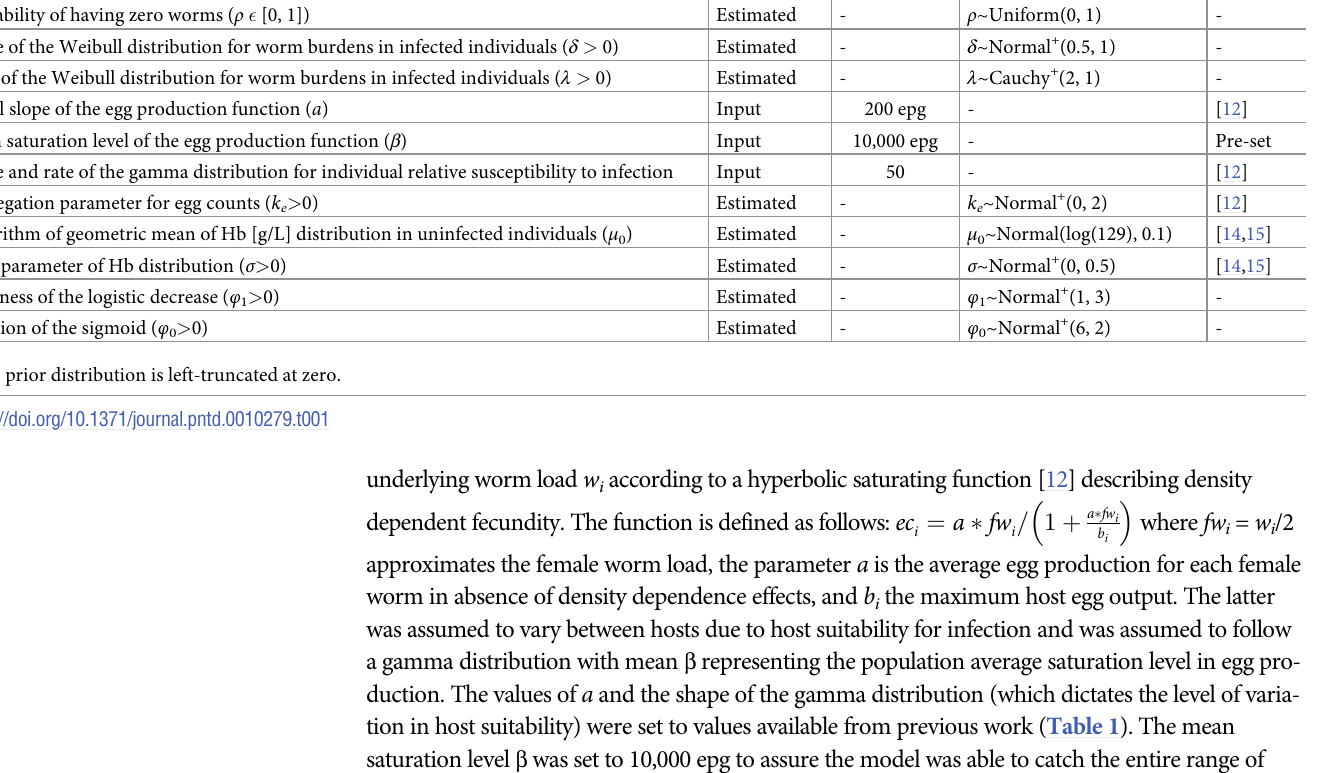
Table 1. Parameters employed in the model. The parameters can be either given in input or estimated from the model. For input parameters the corresponding value is reported, the prior distribution for the Bayesian estimation otherwise. When available, the source of the information is cited. Prior distributions are parameterised in terms of mean and standard deviation (normal) or scale